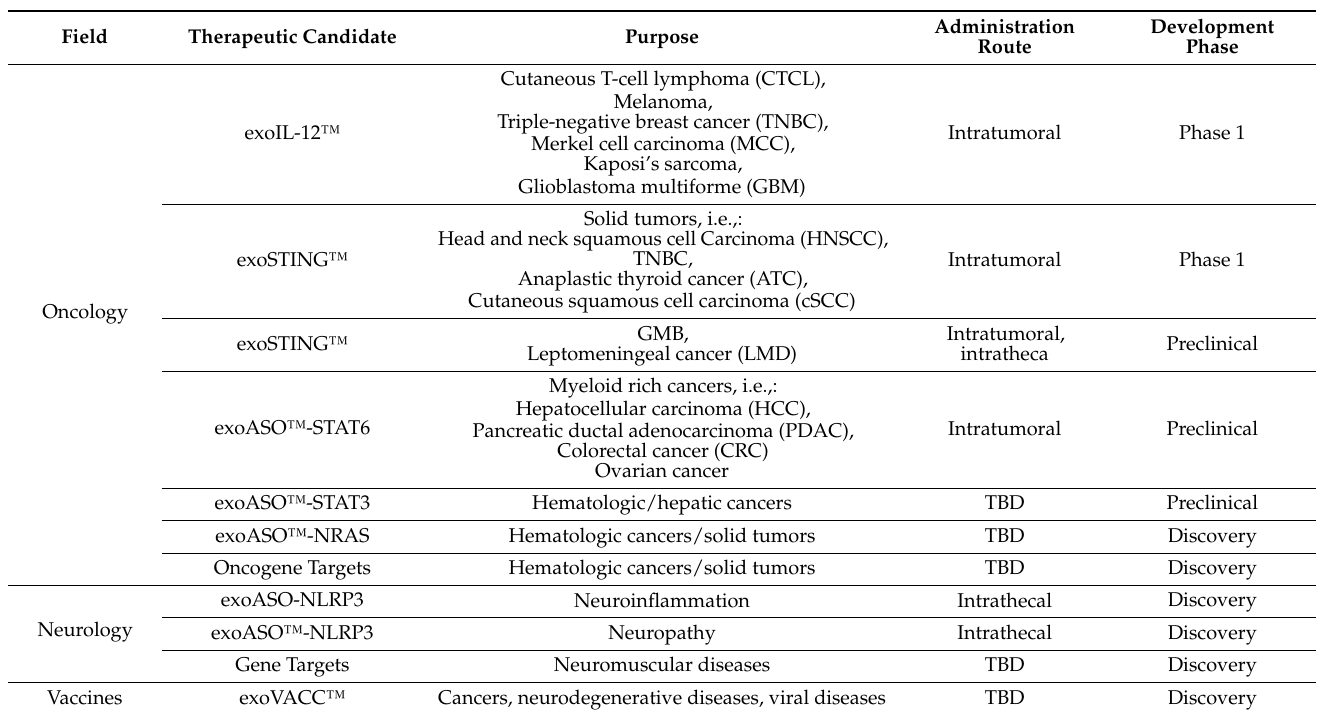
Table 7. Exploring engEx therapeutic candidates from Codiak Biosciences